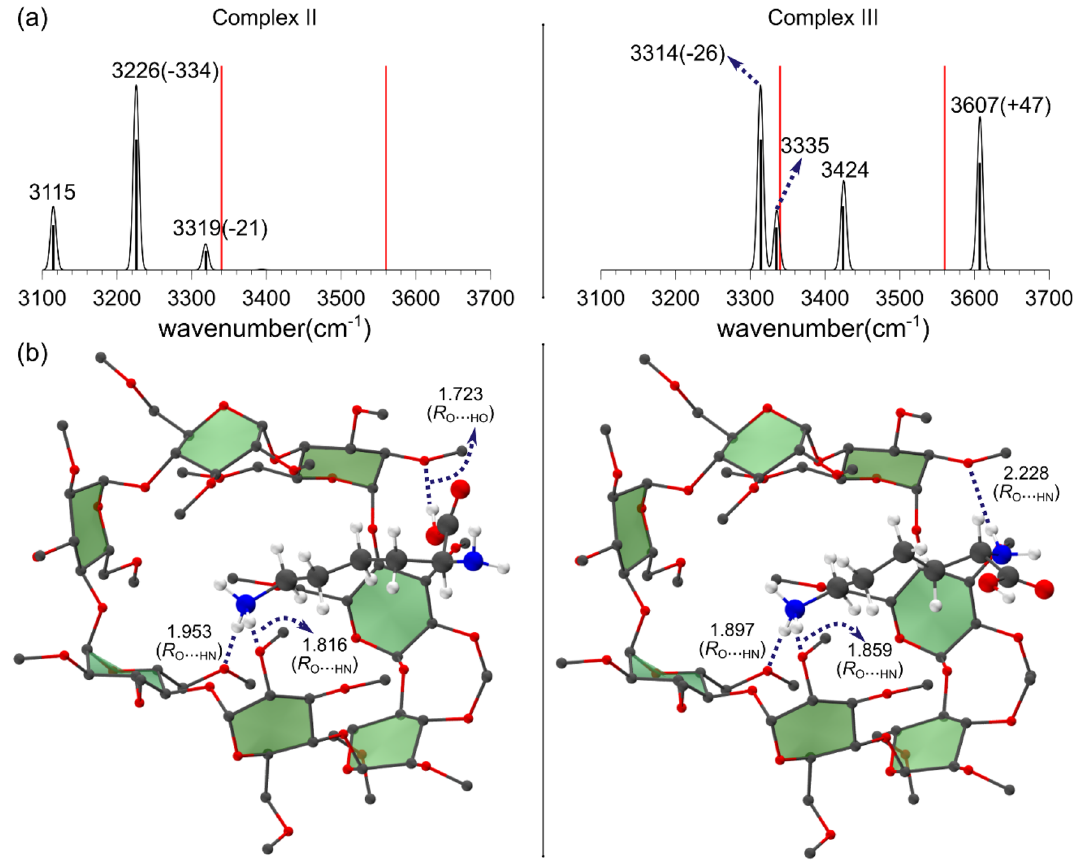
Figure 2. ( a ) Theoretical IR spectra and ( b ) structures of lower Gibbs free energy perm β-CD–protonated L-Lys complexes II and III in gas